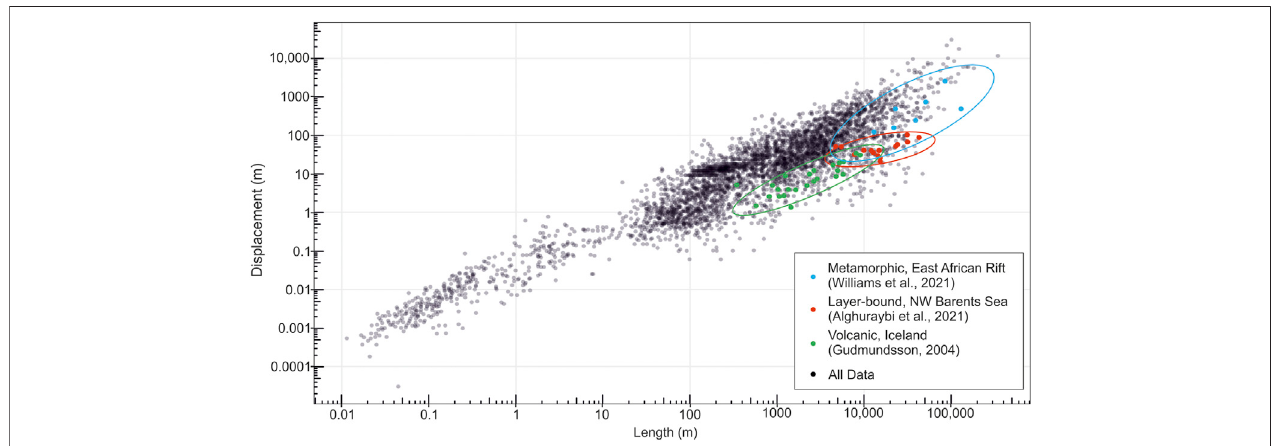
FIGURE 13 | Global D/L dataset (black) for normal faults in log-log space with faults from different host rocks highlighted: metamorphic host rocks from the East African Rift (from Williams et al., 2021), layer-bound faults from the NW Barents Sea in red (from Alghuraybi et al., 2021), and igneous host rocks from Iceland (from Gudmundsson, 2004).